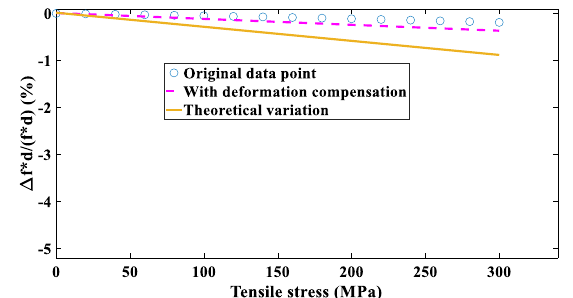
Figure 10 Relative variation of f*d of S1-ZGV with tensile stress. Blue dots refer to original measurement data. Yellow solid line